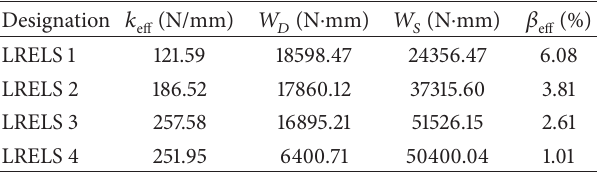
Table 7: Effective stiffness, damping, and energy dissipation in the vertical